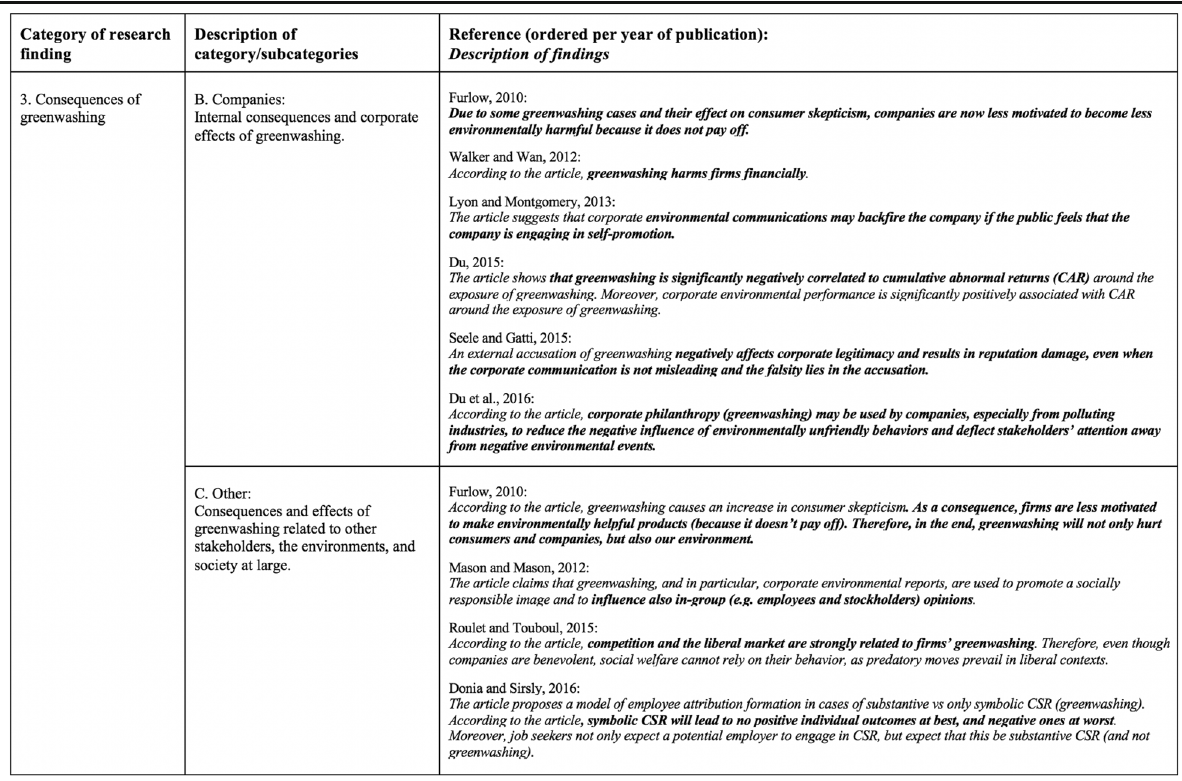
Table 6 Analysis of research findings related to Category 3B and